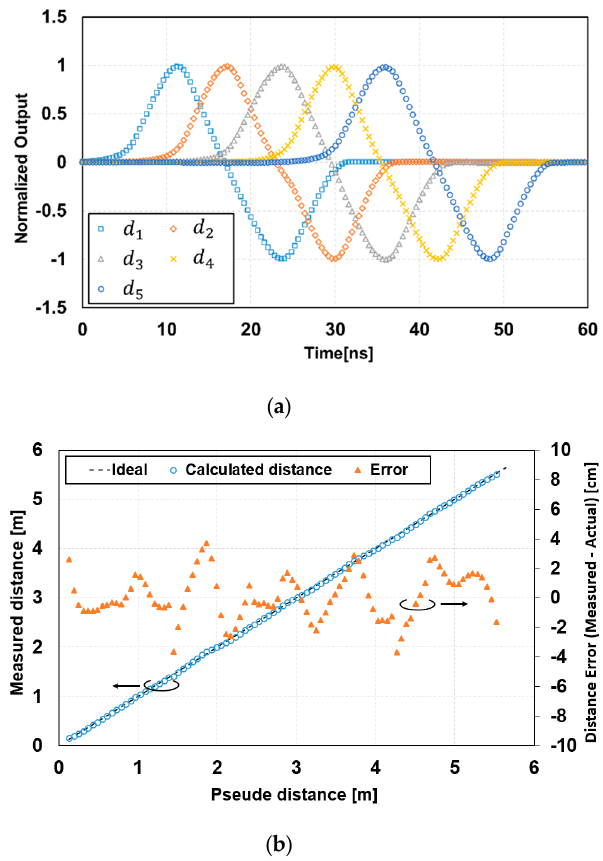
Figure 9. Differential responses and calculated distances using the normalized response curves: ( a ) differences of two signal-tap outputs and ( b ) calculated distance with seven signal-tap outputs versus the pseudo distance.